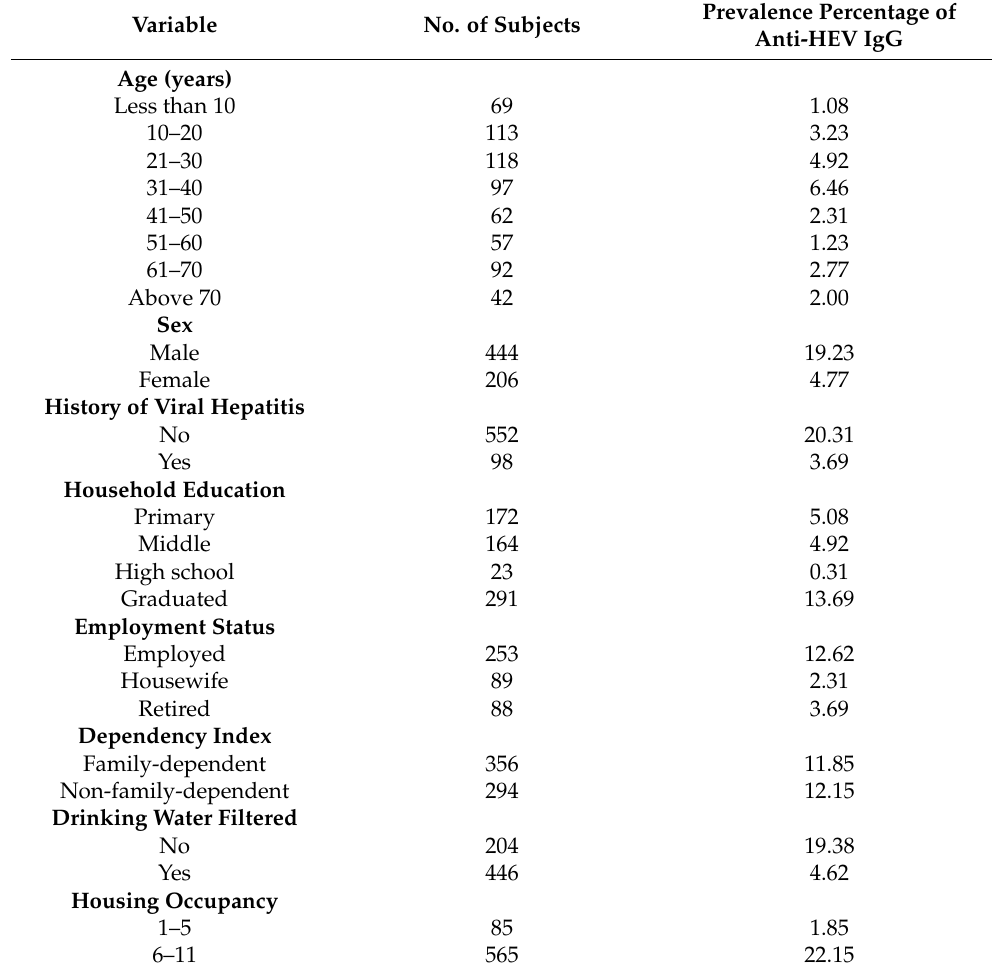
Table 1. Prevalence of anti-HEV IgG antibodies according to individual and household-level risk factors.